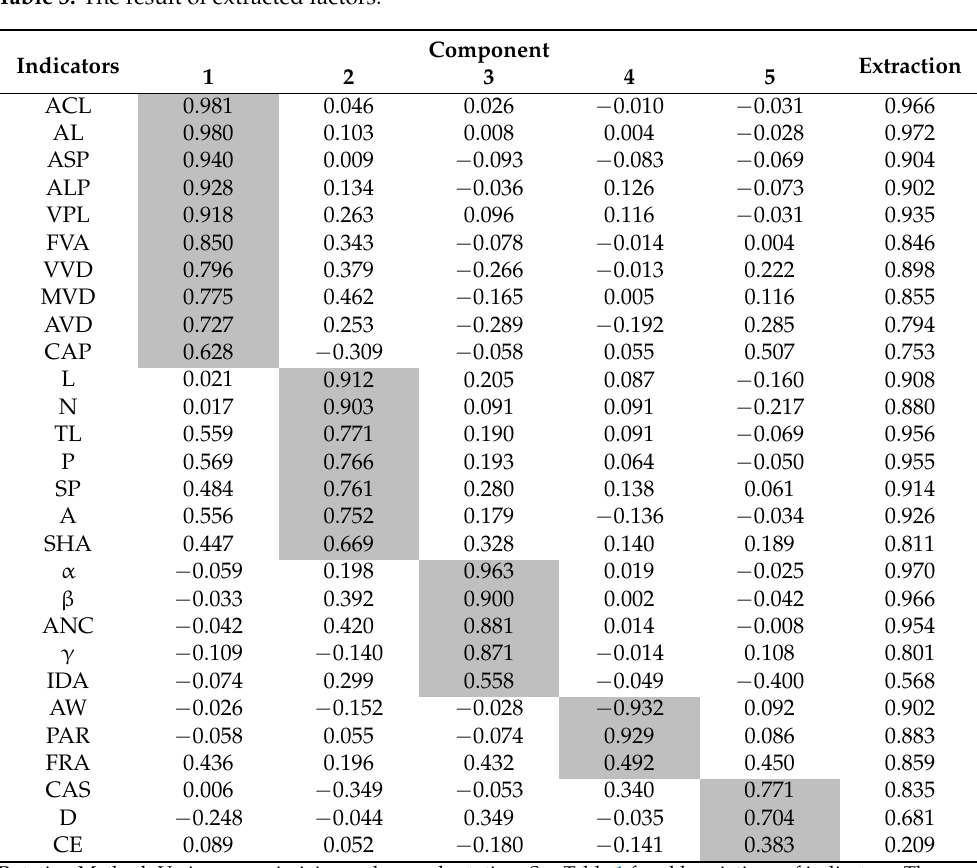
Table 3. The result of extracted